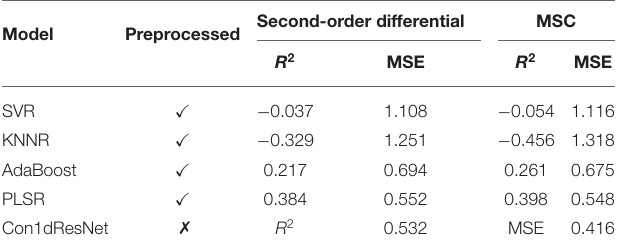
TABLE 4 | R 2 and MSE of estimated SSC for each model with all sample.